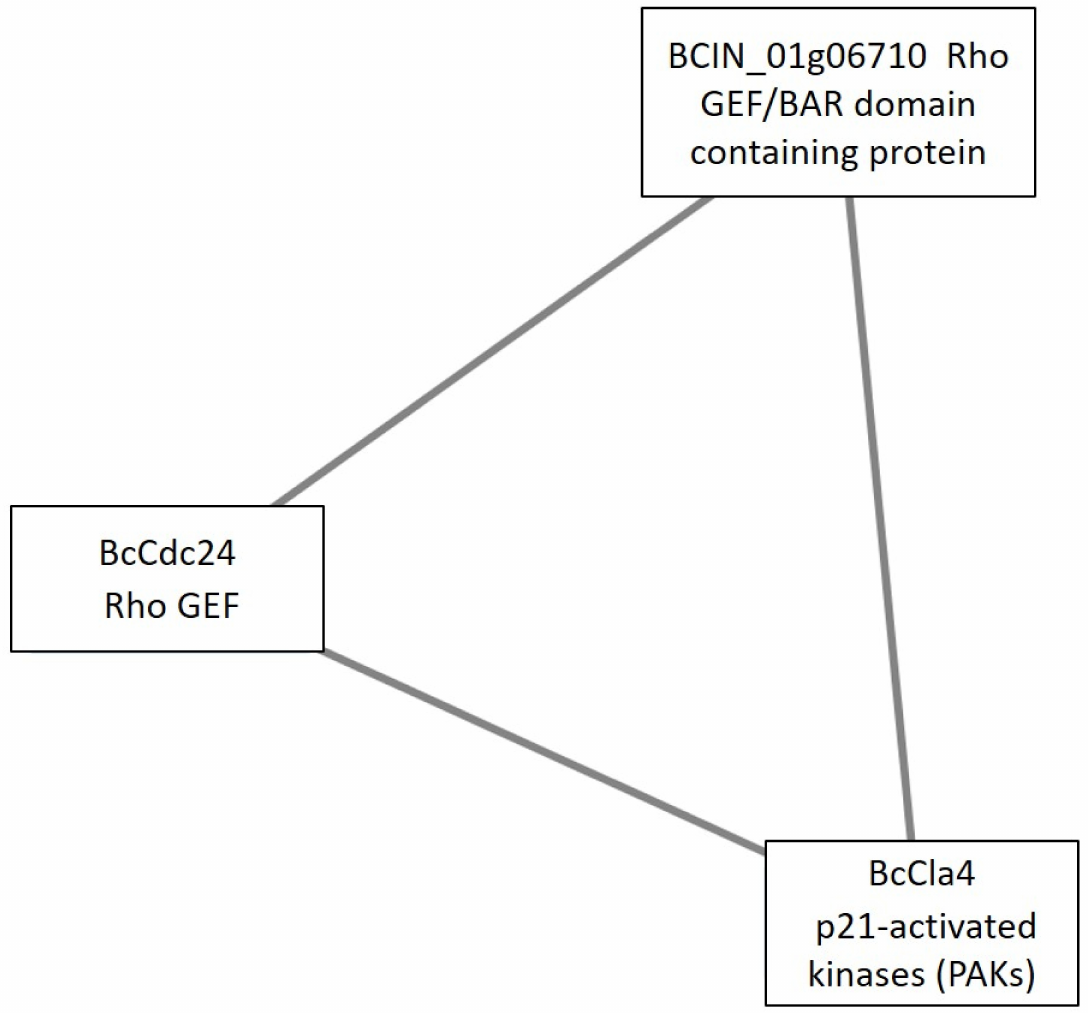
Figure 11. Cluster 14: signaling cluster under the TCW condition. Clusters were obtained analyzing STRING networks of proteins, exclusively identified or overexpressed in B. cinerea proteomes (membranome, phosphoproteome, phosphomem- branome, and secretome) under TCW with